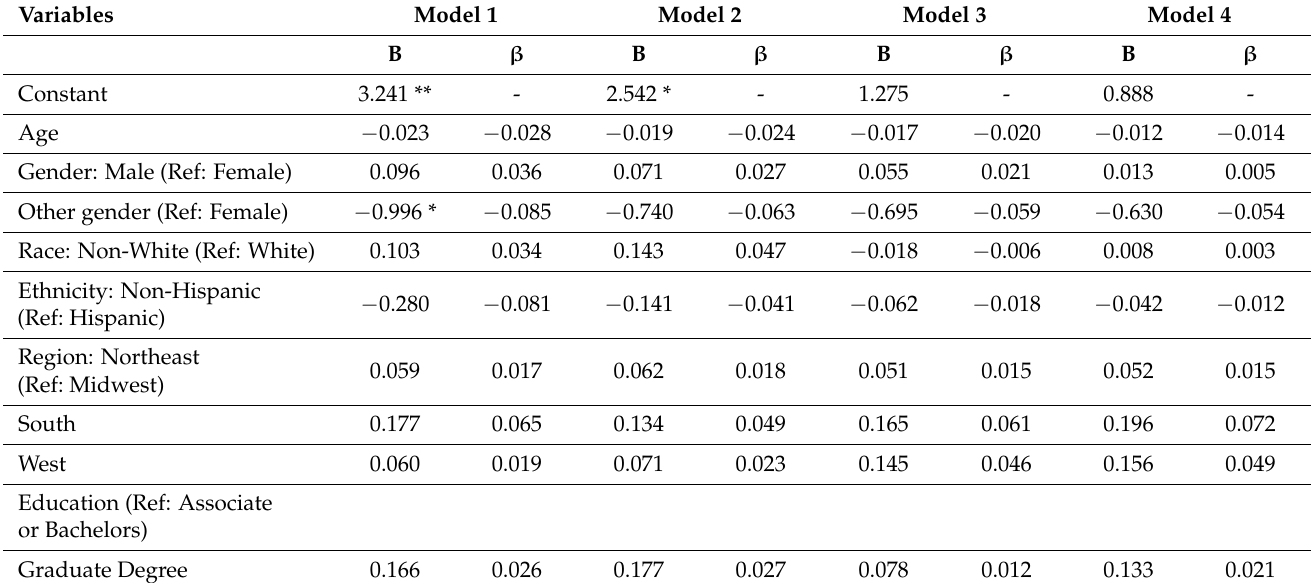
Table 6. Hierarchical multiple regression to predict the likelihood of initiation of vaping quitting (N =